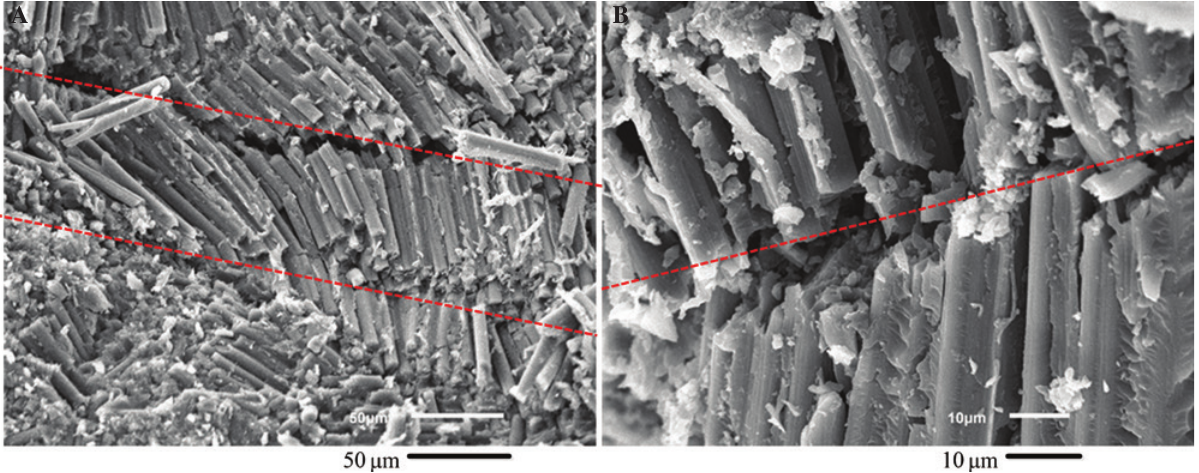
Figure 3: The microscopic failure morphologies of the longitudinal compression. (A) At an amplification rate of 50 m m; (B) at an amplifica- tion rate of 10 m m.